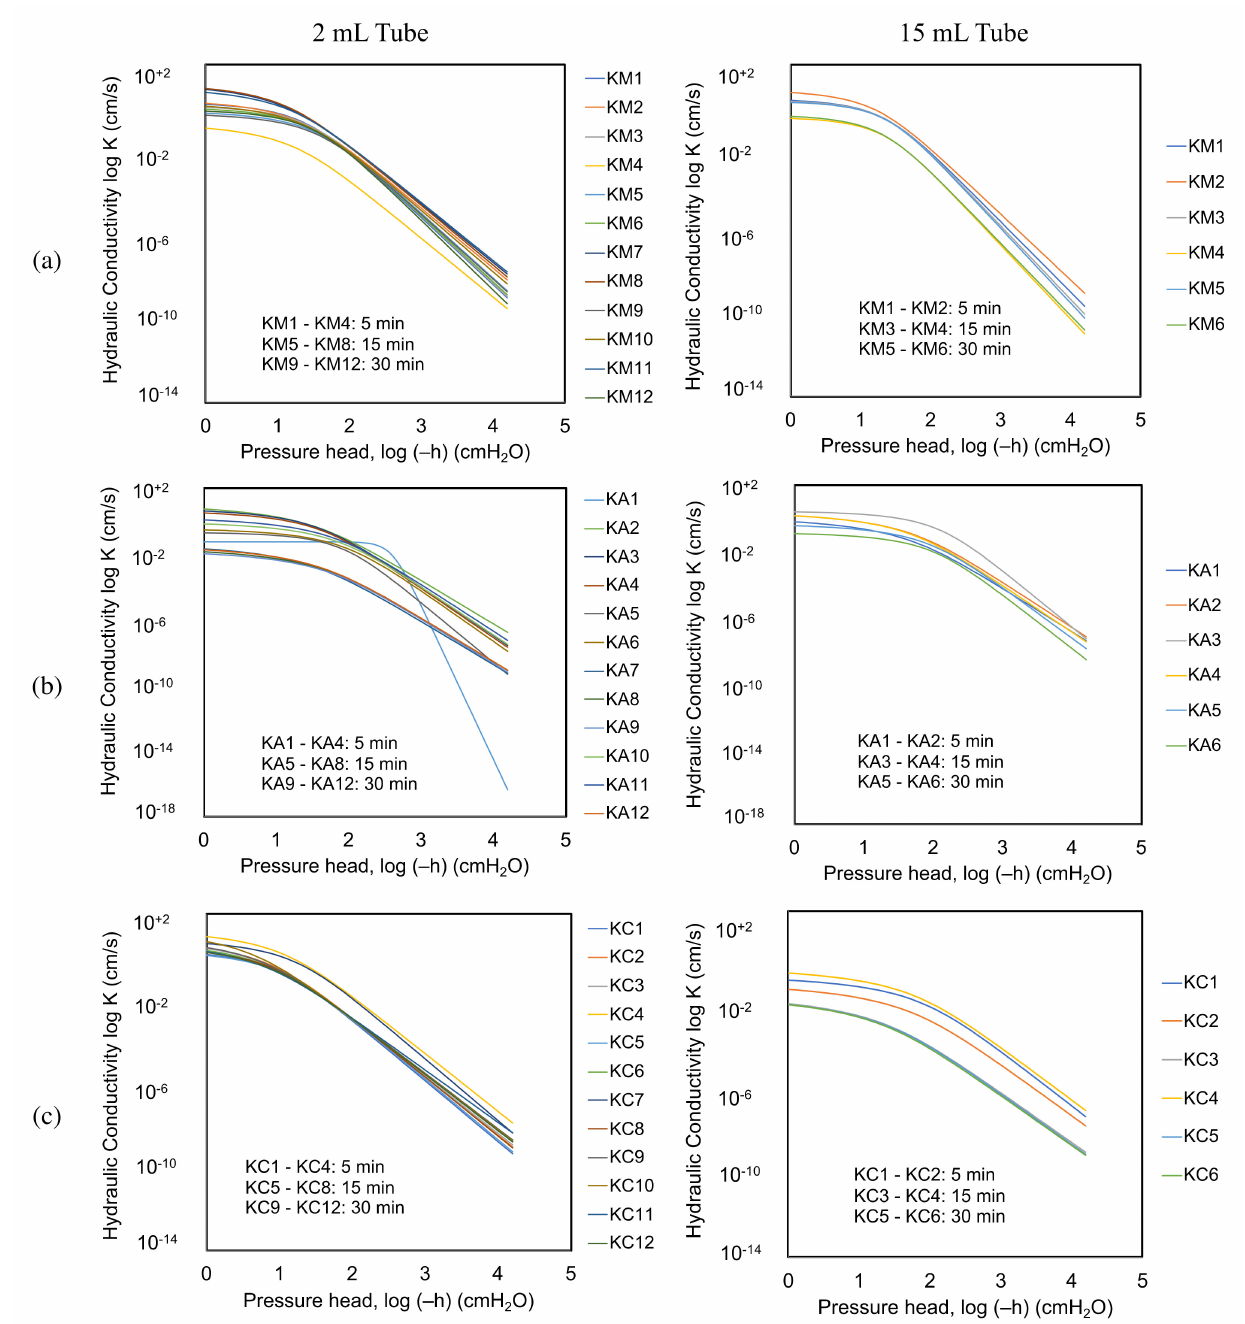
Figure 7. Optimized hydraulic conductivity functions of 2 mL and 15 mL tubes: ( a ) Decomposed granite soil (Masa soil); ( b ) Volcanic ash soil (Andisol soil); ( c ) Paddy